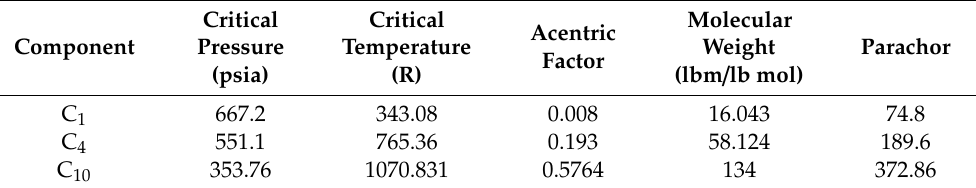
Table 2. Compositional data for the C 1 /C 4 /C 10 system.